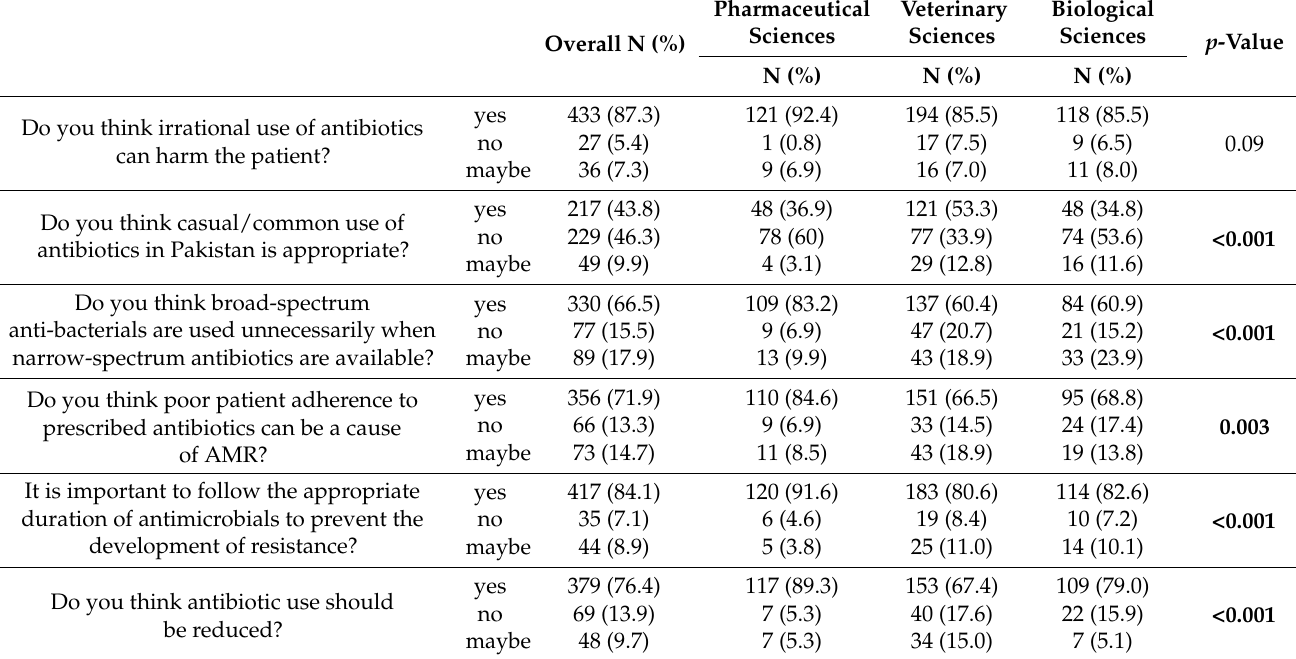
Table 3. Participant’s perception of antimicrobial resistance (AMR).